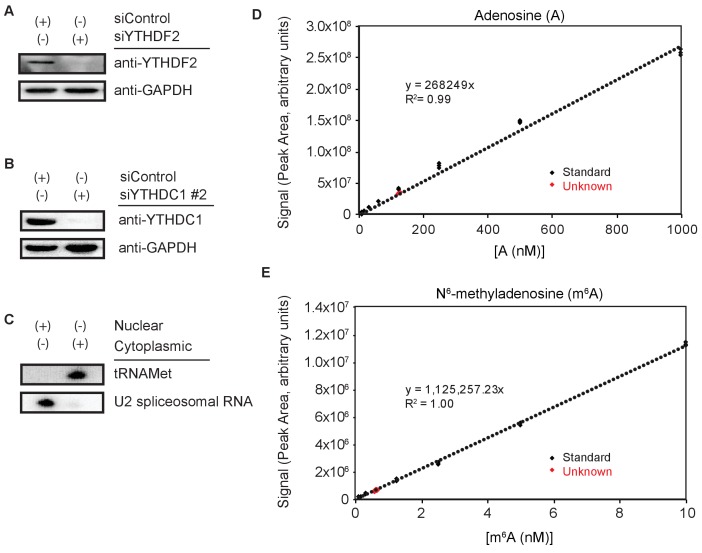
Representative western blots for siRNA knockdown efficiency and northern blot nuclear and cytoplasmic RNA isolation.Calibration and unknown determination for LC-MS/MS quantification of m6A/A. (A) Representative western blot for YTHDF2 knockdown efficiency. (B) Representative Western blot for YTHDC1 knockdown efficiency. (C) Northern blot of nuclear and cytoplasmic RNA. (D,E) Representative data from LC-MS/MS for A and m6A. Standards curves (black) are generated, and unknown concentrations (red) are calculated.10.7554/eLife.31311.004Figure 1—figure supplement 1—source data 1.Calibration of LC-MS/MS.